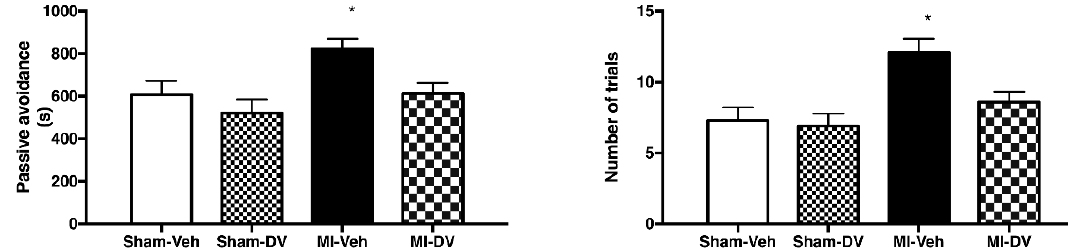
Figure 2. Passive-avoidance step-down test. Left panel: Time to success refers to the time spent by the rats on the platform they should not escape from. Right panel: Number of trials required before learning the task. The performance of MI rats treated with the vehicle was impaired compared to the other groups of rats. MI rats treated with DV performed at the same level as sham rats treated with the vehicle or with DV. n = 9–16 per group. * p < 0.05. MI: myocardial infarction; Veh: vehicle; DV: Desvenlafaxine.